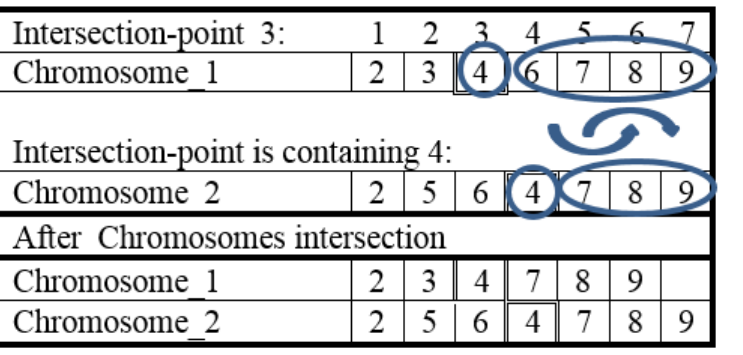
Figure 5. Chromosome intersection samples.